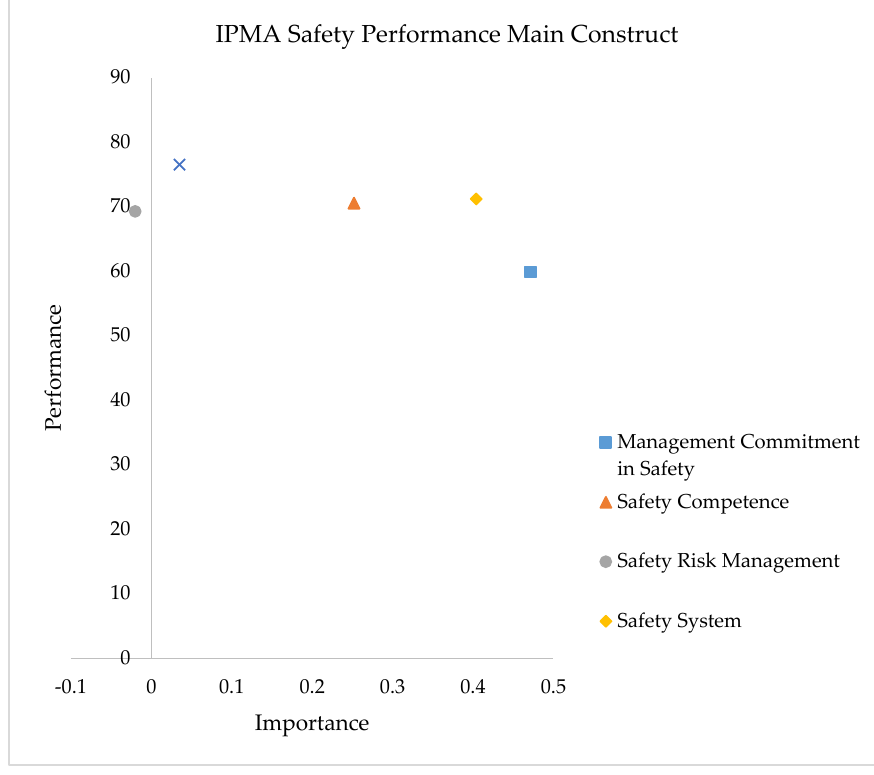
Figure 2. IPMA result based on PLS-SEM analysis in SmartPLS